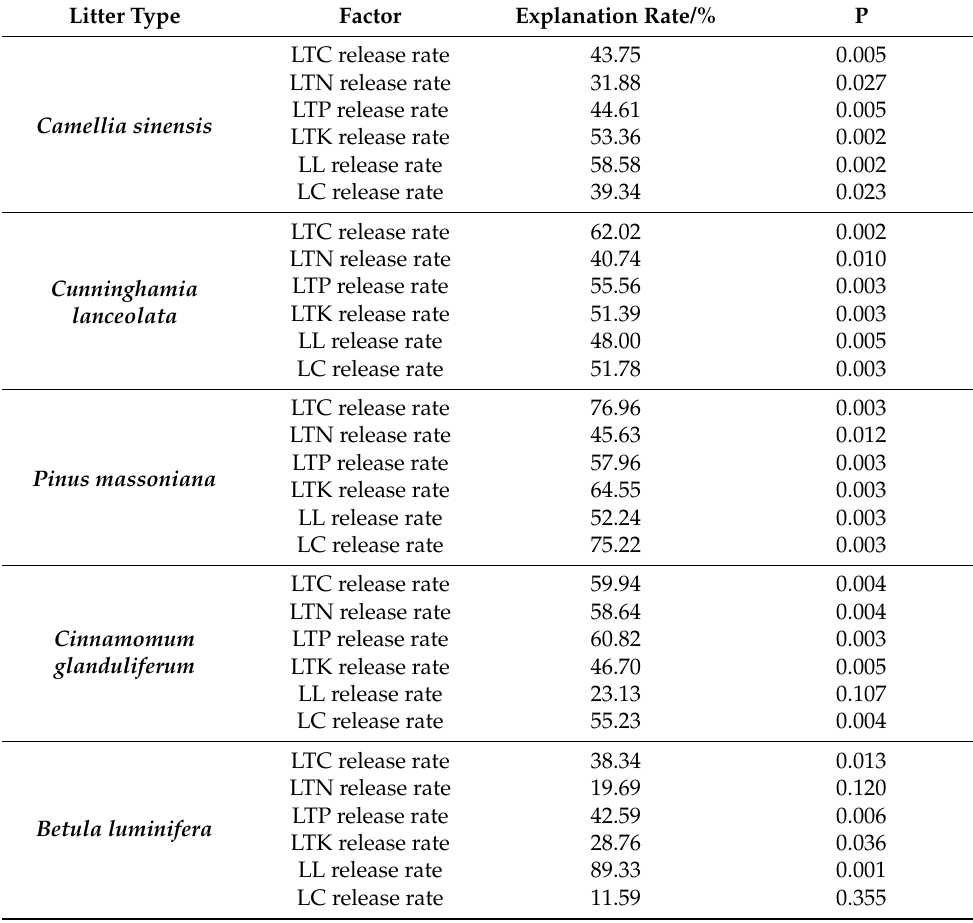
Table 3. Explanation rates of the litter nutrient release rate for soil nutrient